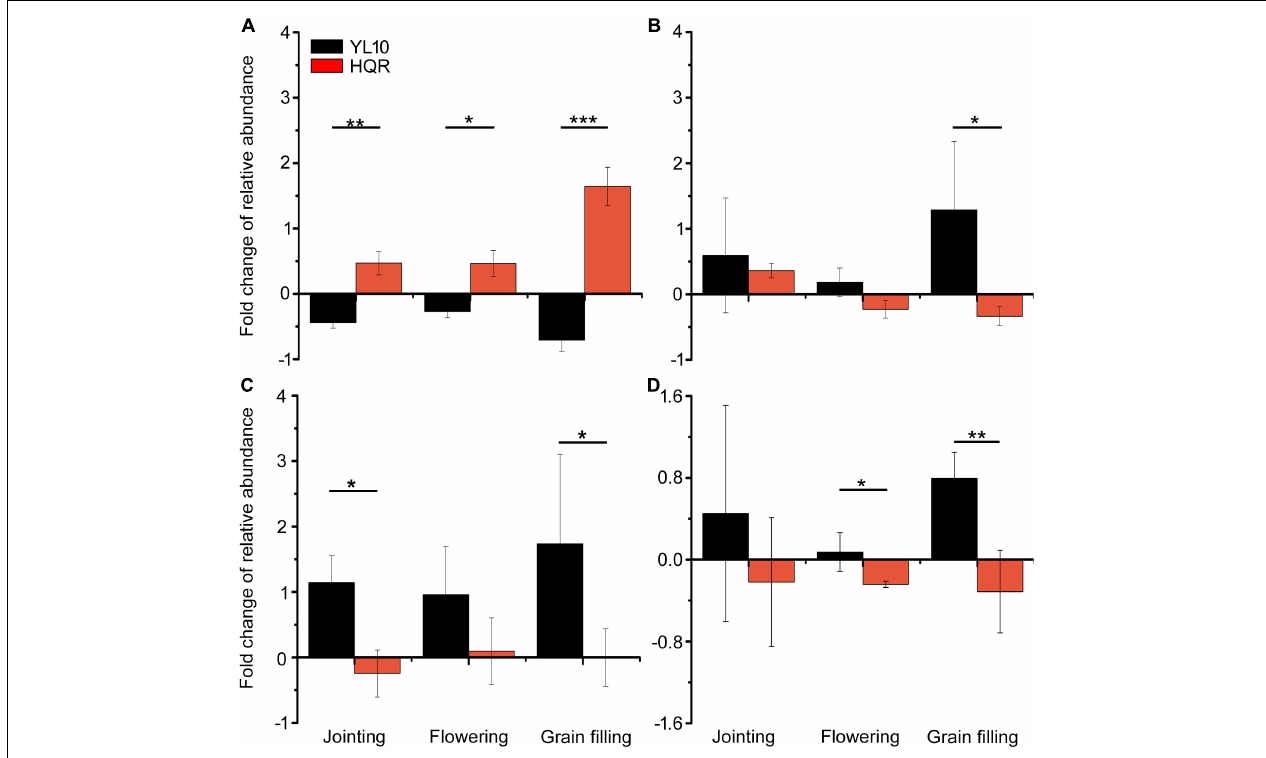
FIGURE 4 | Effects of drought stress on the relative abundances of Acinetobacter (A) , Lysobacter (B) , Streptomyces (C) , and Cellvibrio (D) in the rhizosphere of broomcorn millet. The fold change of each bacterial genera was calculated using the following equation: (relative abundance under drought/relative abundance under control) –1. Error bars are standard error of three independent replicates ( n = 3). ∗ p < 0.05; ∗∗ p < 0.01; ∗∗∗ p < 0.001.